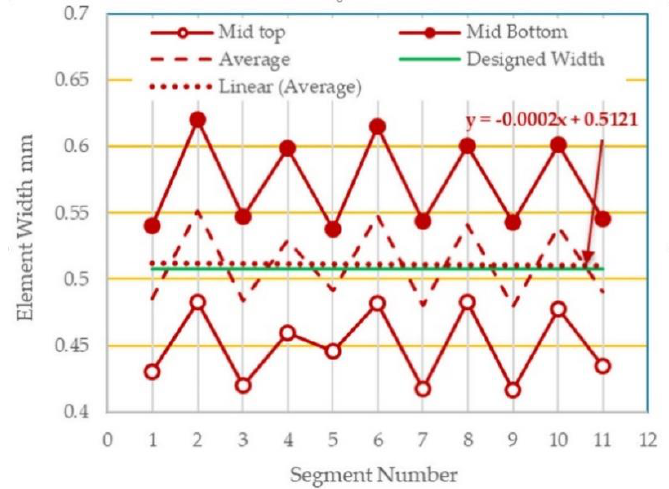
Figure 22. Edge taper resulted from deactivation of the TAJ.